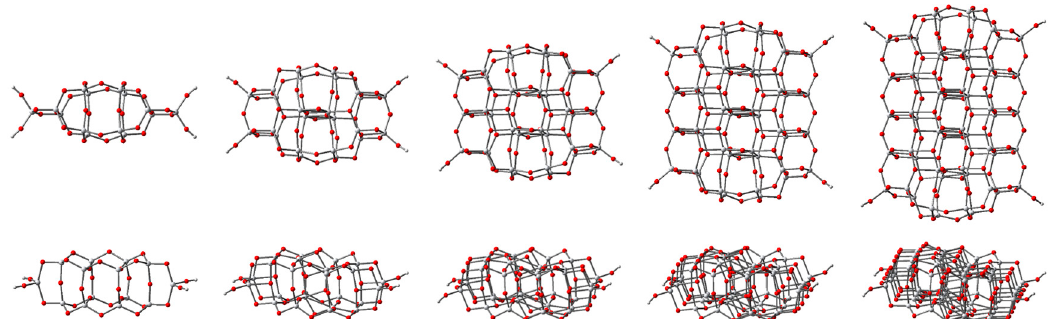
Figure 1. Top and lateral views of the optimized structures of the Ti 14 O 30 H 4 , Ti 24 O 50 H 4 , Ti 34 O 70 H 4 , Ti 44 O 90 H 4 , and Ti 54 O 110 H 4 nanoclusters (from left to right, respectively) modeling the anatase titania (101) surface. The geometry optimization was performed by density functional theory (DFT) at the B3LYP/3-21G(d) level. Atom colors are grey for Ti, red for O, and light grey for H. In the top view, the widths and the lengths reported in Table 1 are measured horizontally and vertically, respectively, as shown in Figure S1 of the Supplementary Materials.